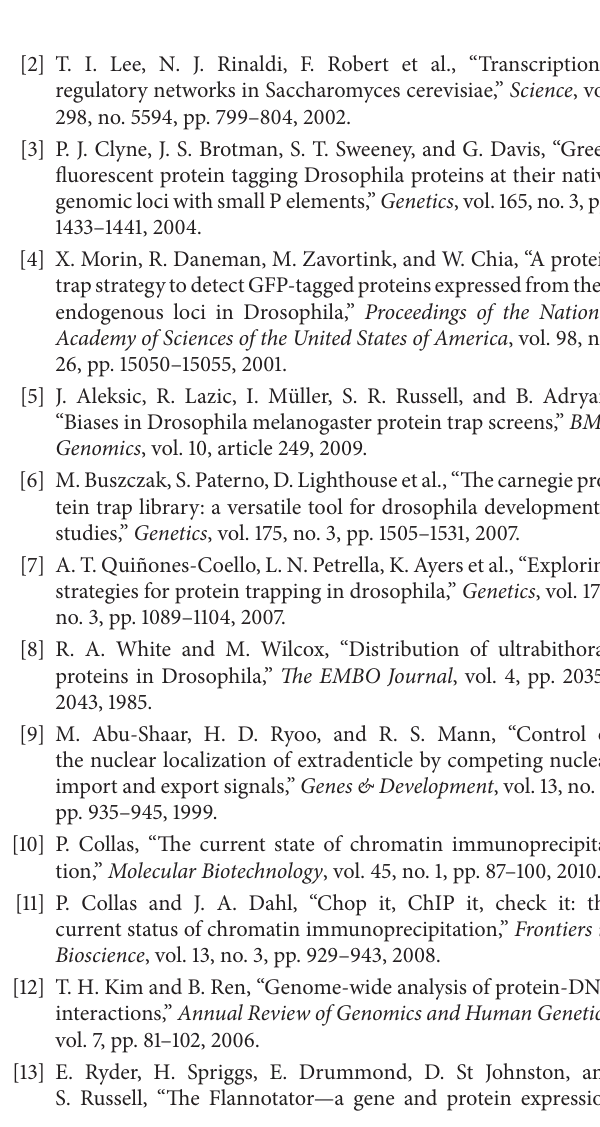
In conclusion, we have demonstrated the feasibility of these two CPTI lines for future potential